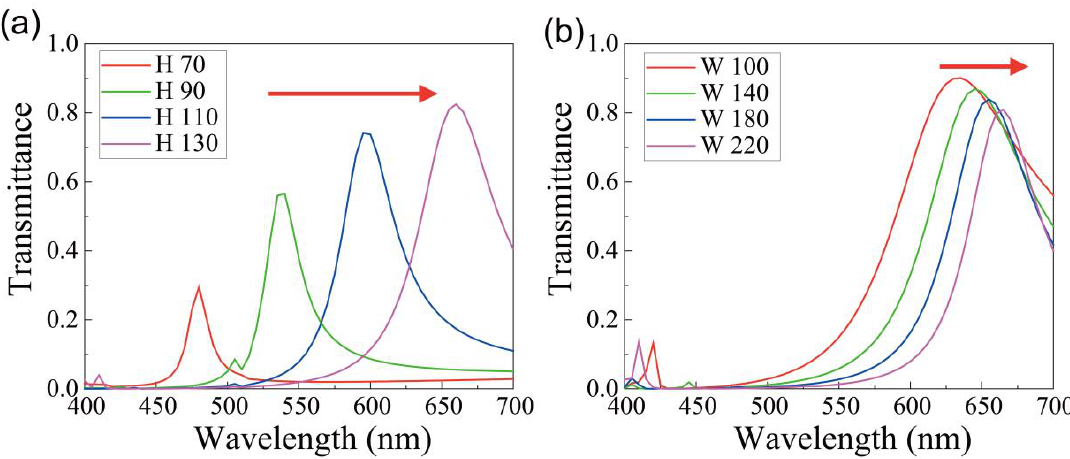
Figure 2. ( a ) Transmittance spectra at different heights ( H ) of the silver block: 70 nm (red), 90 nm (green), 110 nm (blue), and 130 nm (magenta). The width ( W ) and slot thickness ( t ) are fixed to 200 and 20 nm, respectively; ( b ) Transmittance spectra for different widths of the silver block: 100 nm (red), 140 nm (green), 180 nm (blue), and 220 nm (magenta). The height and slot thickness are fixed to 130 and 20 nm, respectively.